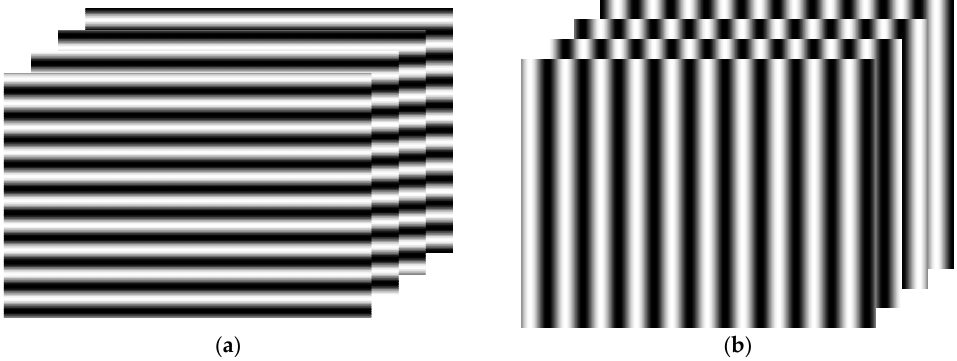
Figure 3. Orthogonal fringe pattern sets. ( a ) Horizontal direction and ( b ) vertical direction.